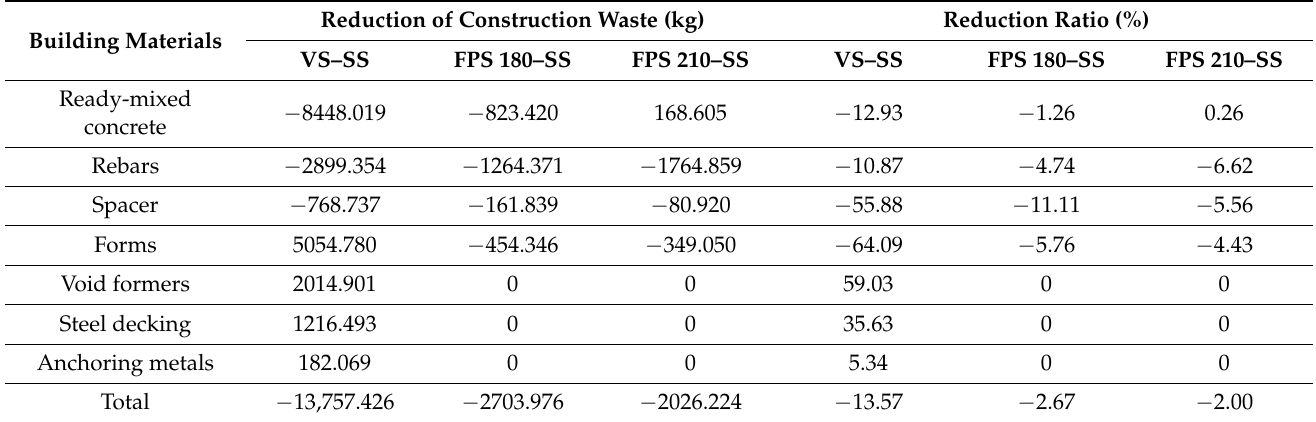
Table 4. Waste reduction of the different structural